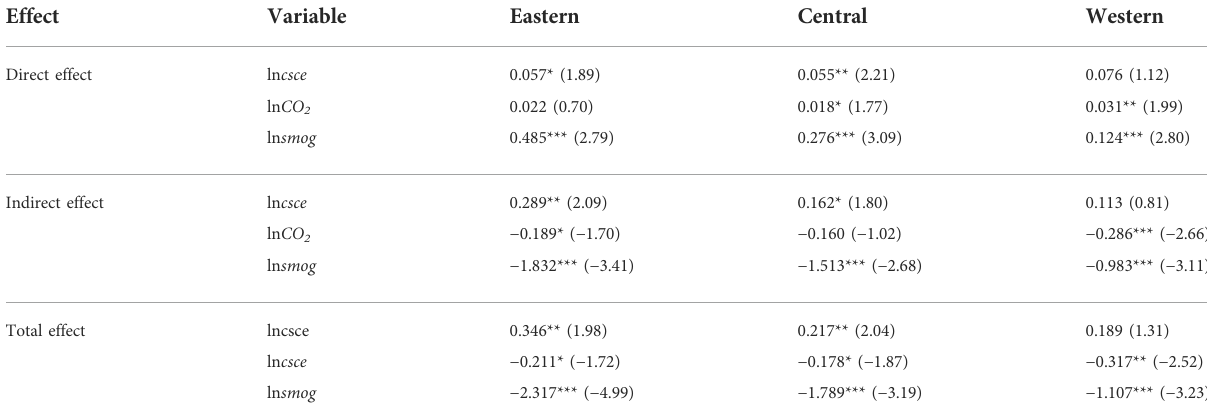
TABLE 6 The effects coef fi cients of the digital economy on synergistic management of carbon-haze in different